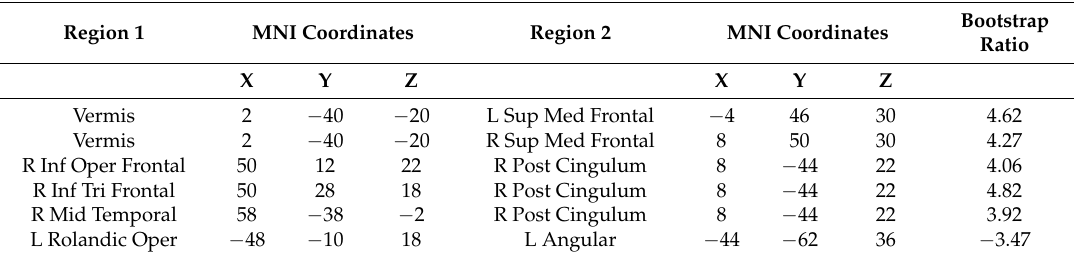
Table A3. Areas of altered functional connectivity observed among individuals with MCI associated with standard deviation in